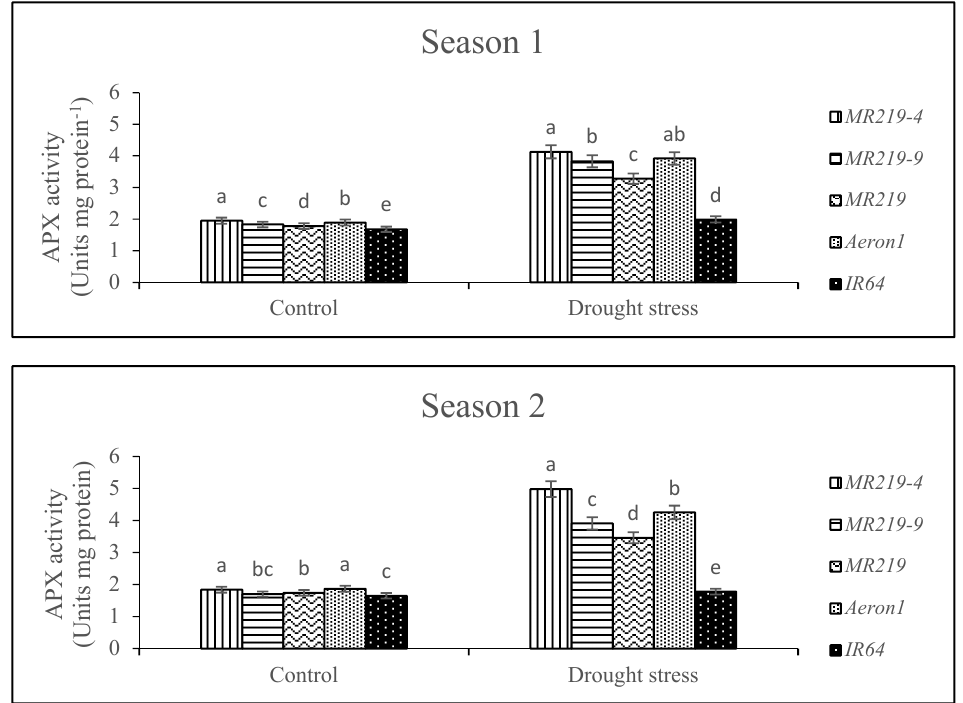
Figure 4. Effect of drought stress treatment on APX activities in rice genotypes. Vertical bars represent ± standard error. Values within drought stress treatment with the different letter are significantly different based on comparison using DNMRT at p ≤ 0.01 ( n = 20).